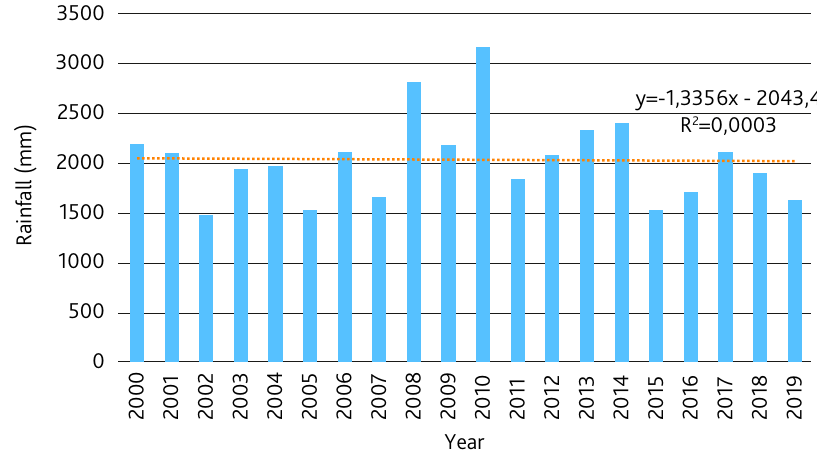
Figure 9. Trend of Total Annual Rainfall in Pekalongan Region (2000-2019